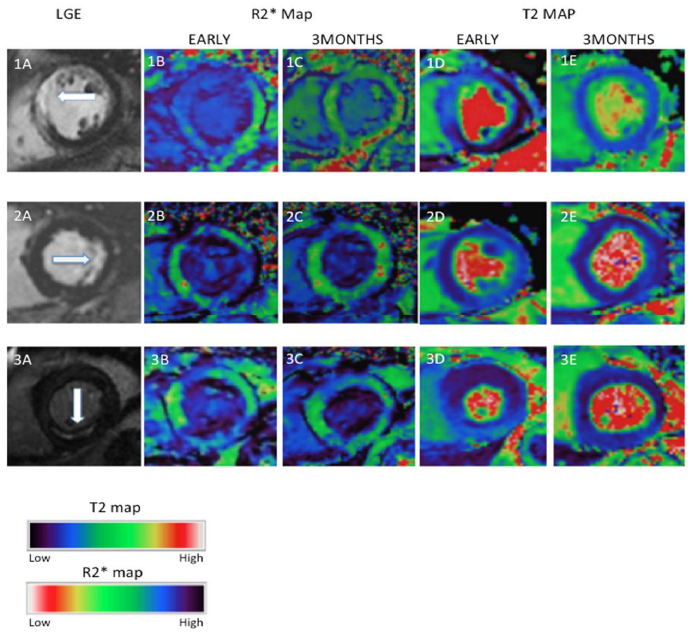
Figure 2. Examples of myocardial oedema and ferumoxytol enhancement in the infarct area after myocardial infarction (MI). Three examples of MI (1, anteroseptal, 2, lateral and 3, inferior) showing LGE on T1-weighted imaging ( 1A – 3A ), ferumoxytol enhancement (R2* maps) ( 1B – 3B,1C – 3C ), and oedema (T2 maps) ( 1D – 3D,1E – 3E ) at early (up to 10 days in ( 1B – 3B,1D – 3D )) and late (3 months in ( 1C – 3C,1E – 3E )) post-MI. Early inflammation and oedema seen on R2* maps (dark region) and T2 maps (light region), respectively, have improved or resolved by three months [31]. Reproduced with permission from Stirrat et al. [31] under a Creative Commons Attribution 4.0 International License.